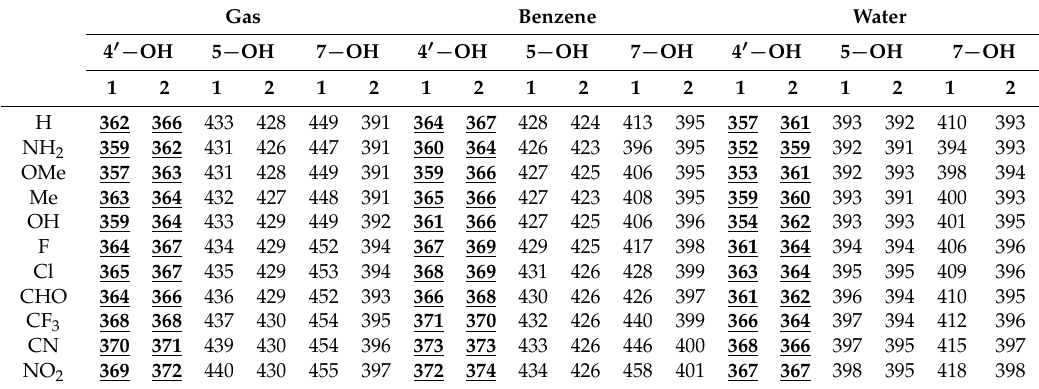
Table 2. O–H bond dissociation enthalpy (BDE) in kJ/mol obtained by the M062X/6-311 + G** method a .